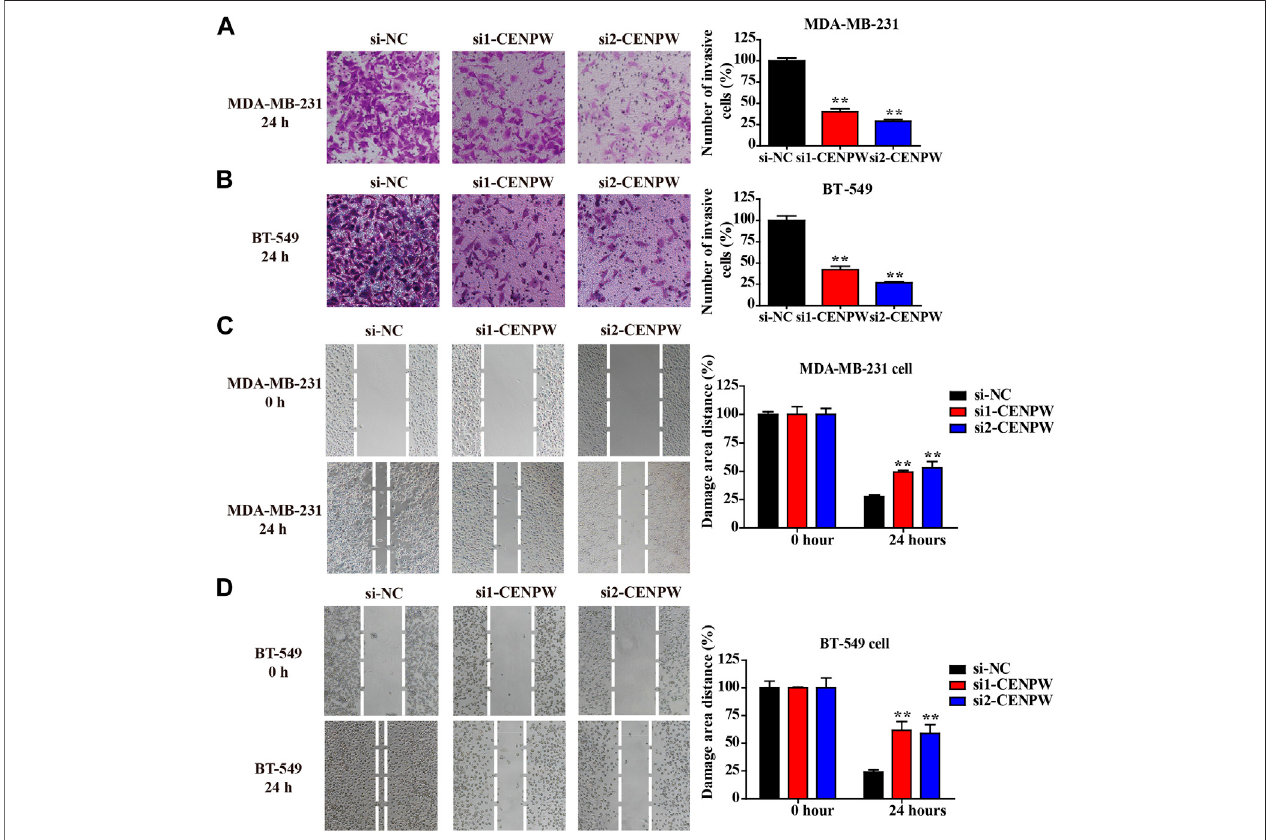
FIGURE 10 | Knockdown of CENPW suppresses breast carcinoma cell invasion and migration. (A,B) The invasive ability was evaluated by transwell assay. (C,D) The migration capacity of control and CENPW knockdown cells was detected by wound healing assay. The statistical column diagrams are displayed on the right. * p < 0.05, ** p < 0.01 compared with si-NC